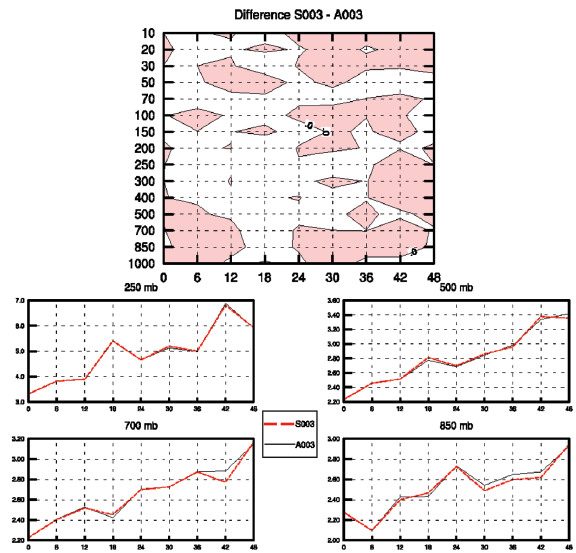
Fig. 19. Top: vertical profile of the wind speed rmse difference be- tween a run with (S003) and without SURFEX (A003) as a function of forecast range averaged over a summer period (18 July 2010– 15 August 2010) and over the whole domain. Red shaded areas mean that the use of SURFEX improve the scores. Bottom: wind speed rmse of the run with (red line) and without (black line) SUR- FEX at different pressure levels (250, 500, 700 and